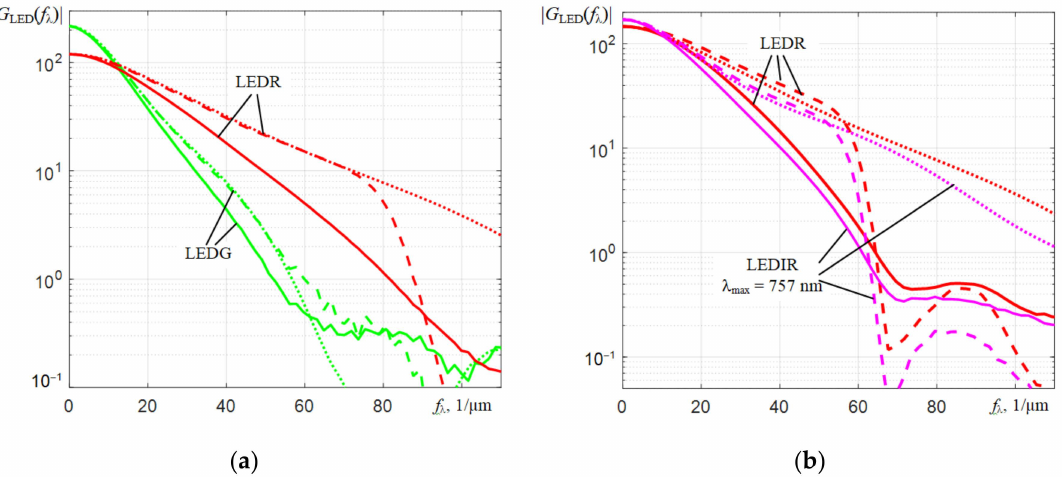
Figure 12. Moduli of the Fourier transforms of the original spectra (solid lines) and the corrected (dashed lines) of the LEDs registered by C12880MA ( a ) and C11708MA ( b ), and similar moduli of the Fourier transforms of normalized spectra obtained by AvaSpec 2048L (dotted